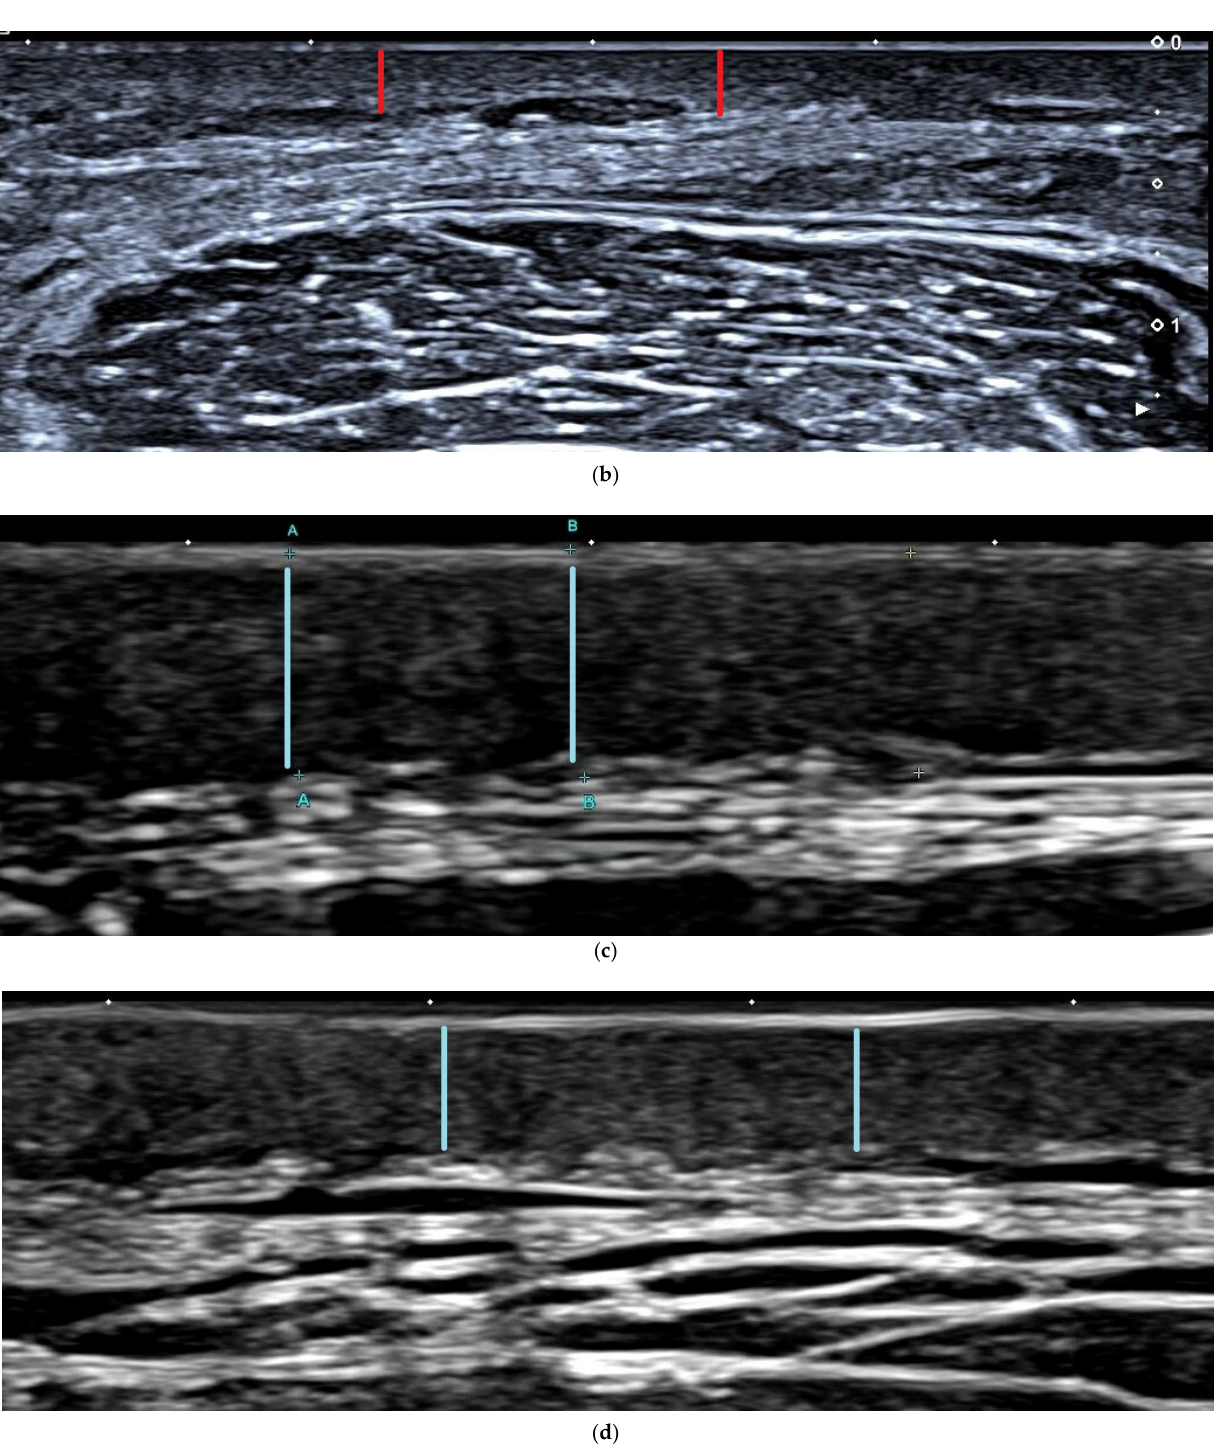
Figure 3. Ultrasonic images of patients four weeks before and after treatment. ( a ) AFL+MTX group patient 4 weeks before treatment. The uppermost layer, the epidermis layer, is hyperechoic (shown with white arrows), and the underlying dermis is hypoechoic (shown with red line) and indistinguishable from the fat layer. ( b ) AFL+MTX group patient 4 weeks after treatment. The dermis is thinner than before (shown with red line) and can be easily distinguished from the fat layer. ( c ) AFL group patient 4 weeks before treatment. The dermis (shown with blue line) is indistinguishable from the fat layer. ( d ) AFL group patient 4 weeks after treatment. The dermis is thinner (shown with blue line) than before and clearly identified with the fat